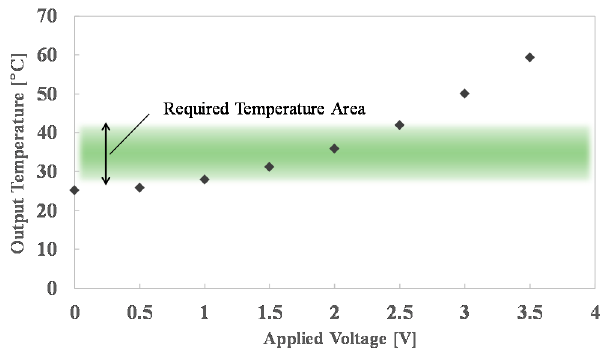
Figure 6. Relationship between the output temperature and applied voltage in the thin film